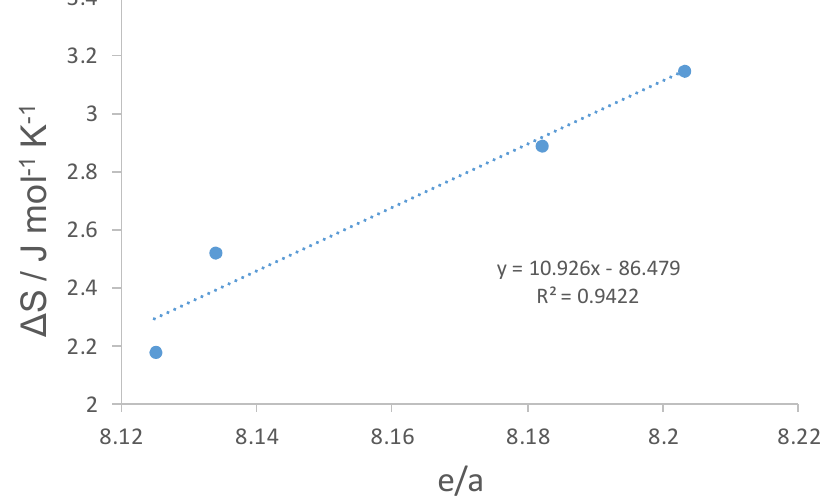
Crystals 2020 , 10 , x FOR PEER REVIEW Figure 6. Enthalpy of the structural transformation versus e / a. Figure 6. Enthalpy of the structural transformation versus e/a.